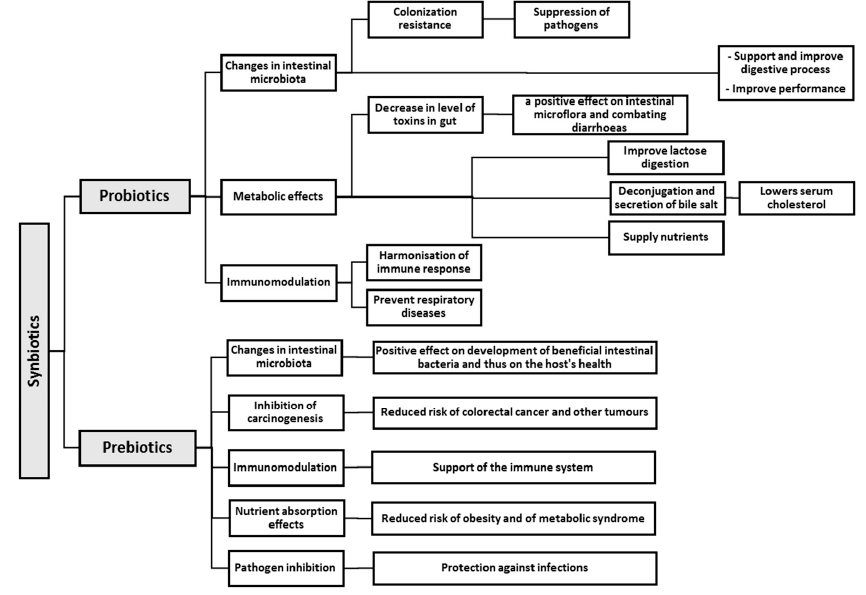
Figure 1. Mechanisms of action of synbiotics and their effects.